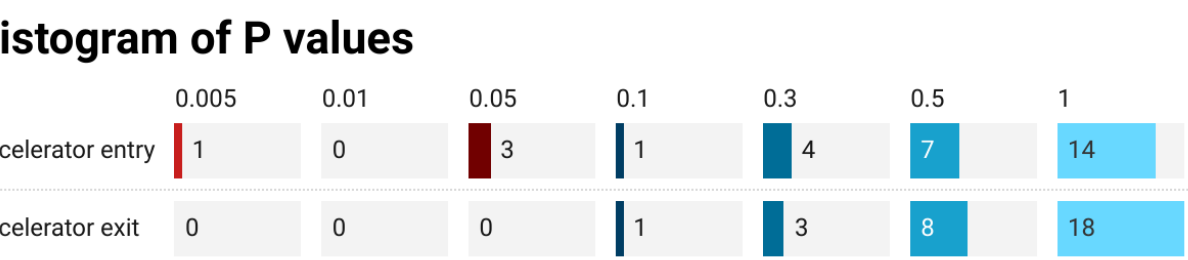
Figure 3. Histograms of Levene test results comparing for equality the variance of the 30 indicators for the COVID and pre‑COVID cohorts at programme entry and exit.